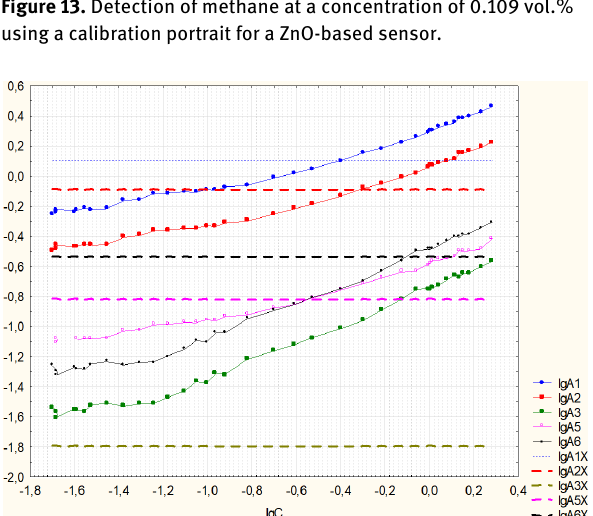
Figure 14. Complete discrepancy of 0.248 vol.% propane in the air to the calibration portrait of methane on ZnO-based